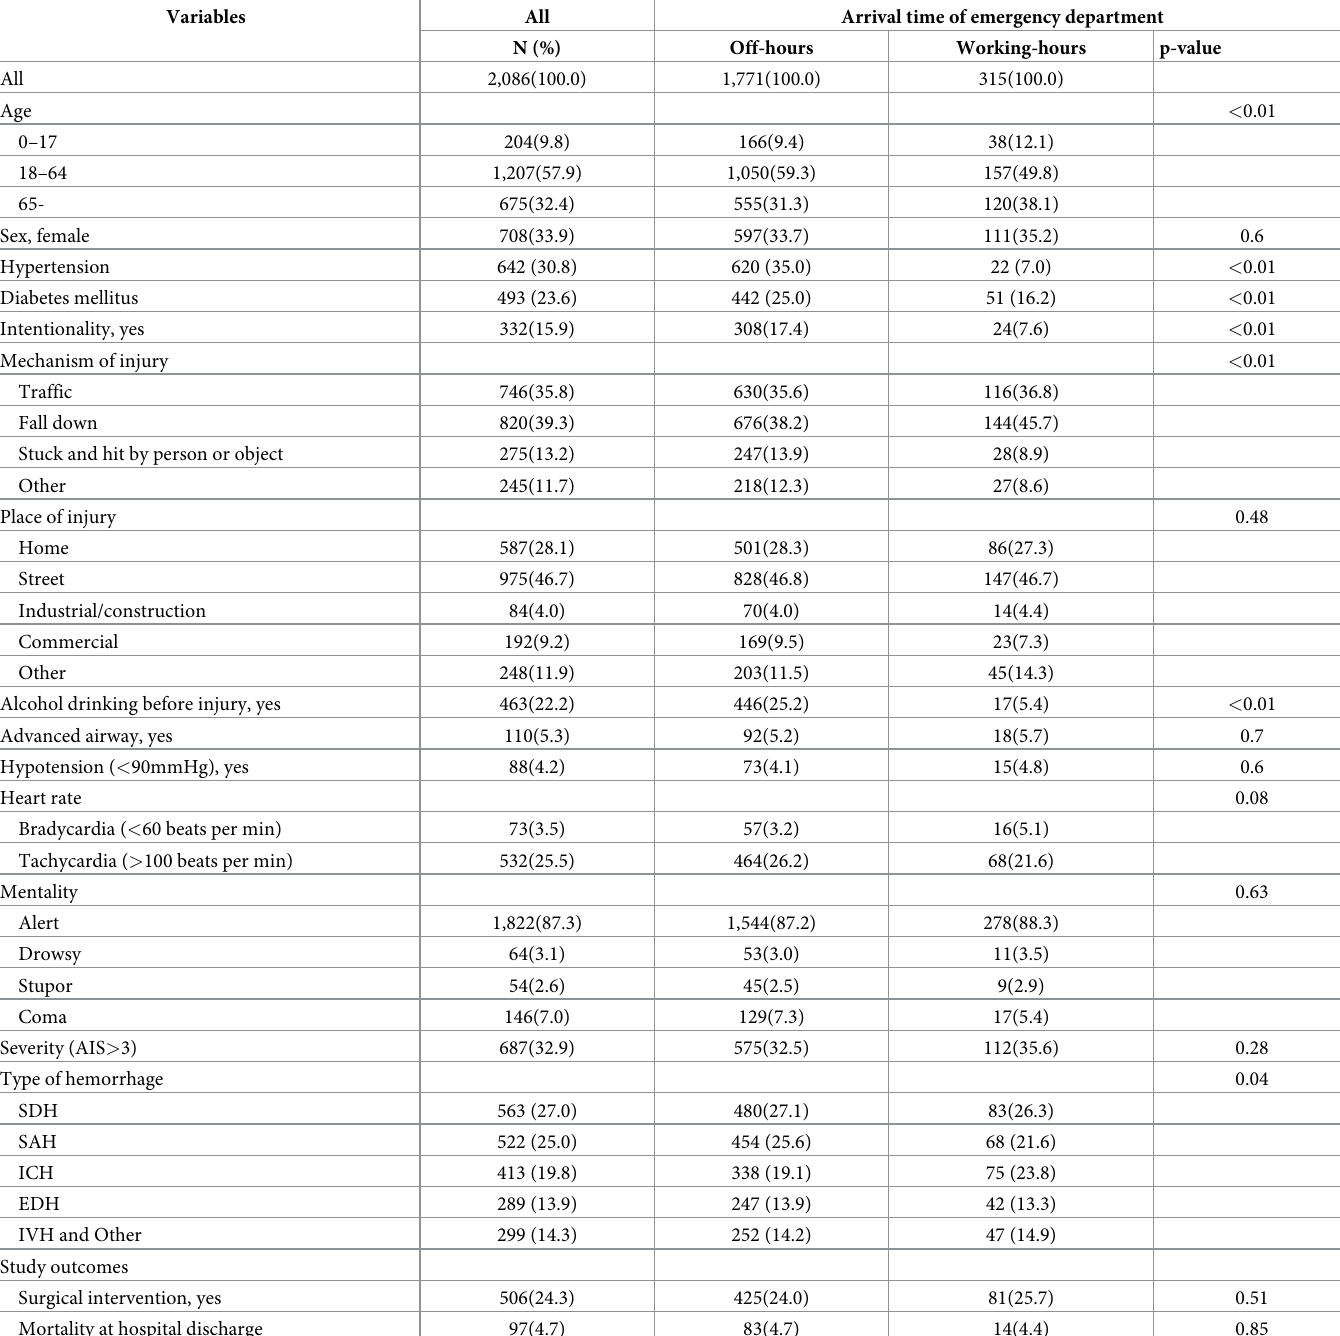
Table 2. Characteristics of the study population according to the arrival time (Off-hours vs. Working-hours) of emergency